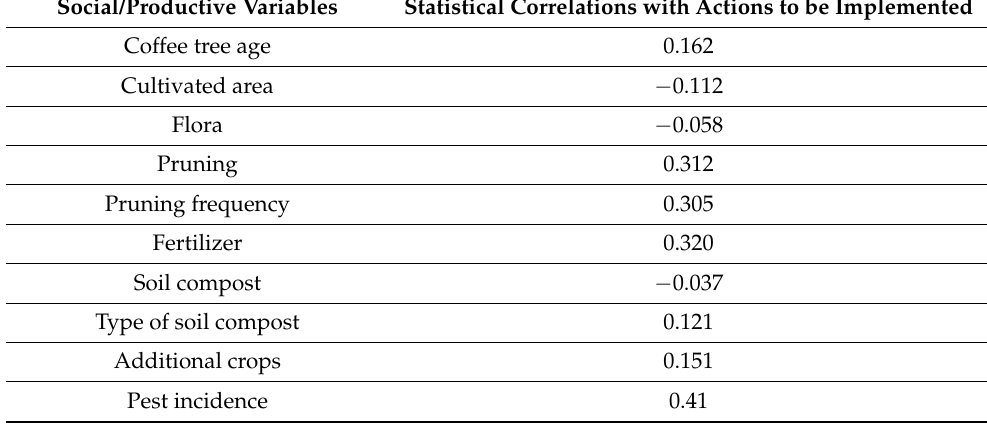
Table 6. Cont. Social/Productive